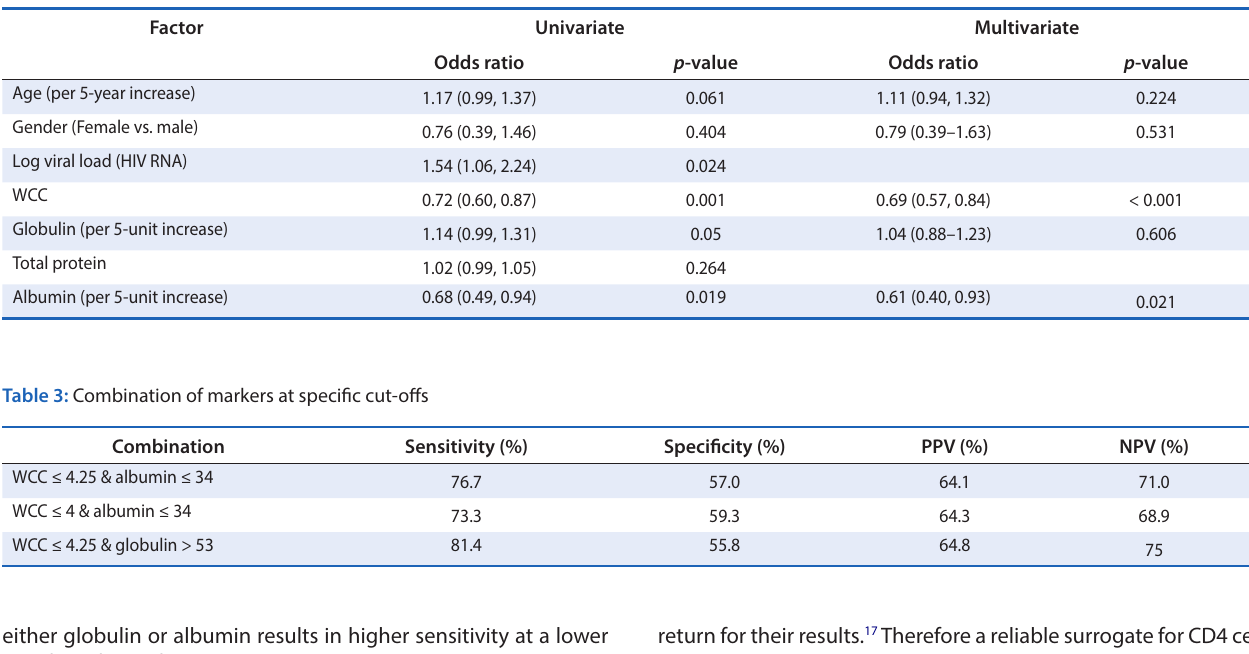
Table 2: Multivariate analysis of the predictors of a CD4 cell count ≤ 200